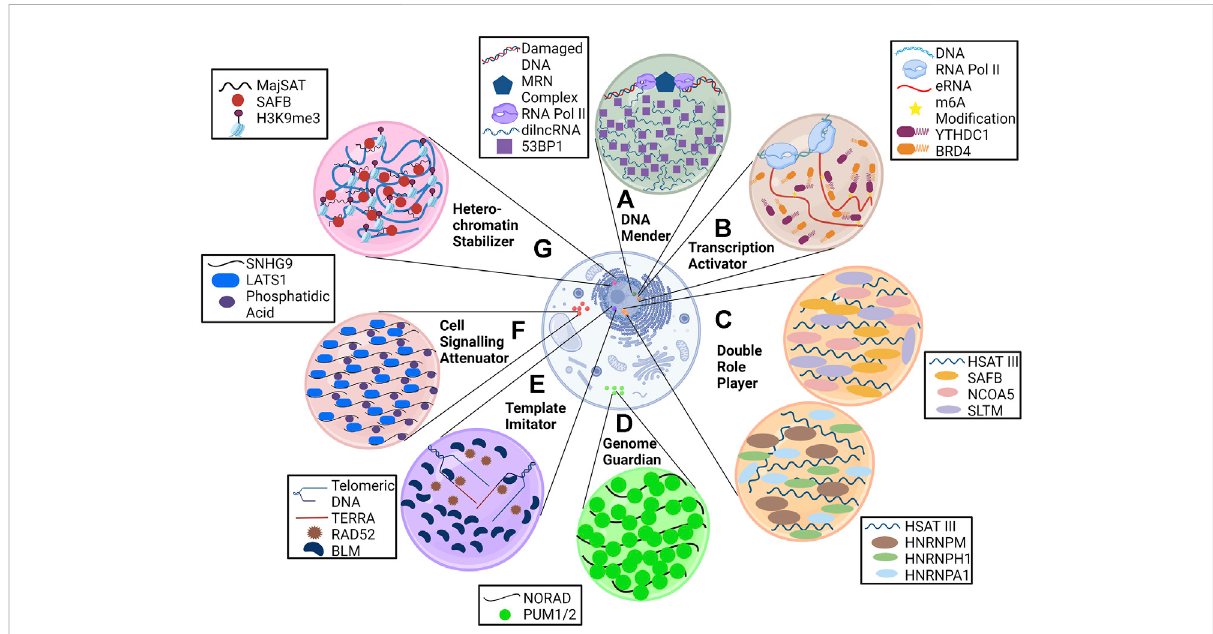
FIGURE 2 LncRNAs are anchors of phase condensates. LncRNAs orchestrate the formation of phase condensates and execute various processes such as (A) DNA repair (dilncRNA), (B) transcription activation (eRNA), (C) pre-mRNA splicing and transcription regulation (HSATIII), (D) genome stabilization (NORAD), (E) alternative lengthening of telomeres (TERRA), and (F) cell signaling